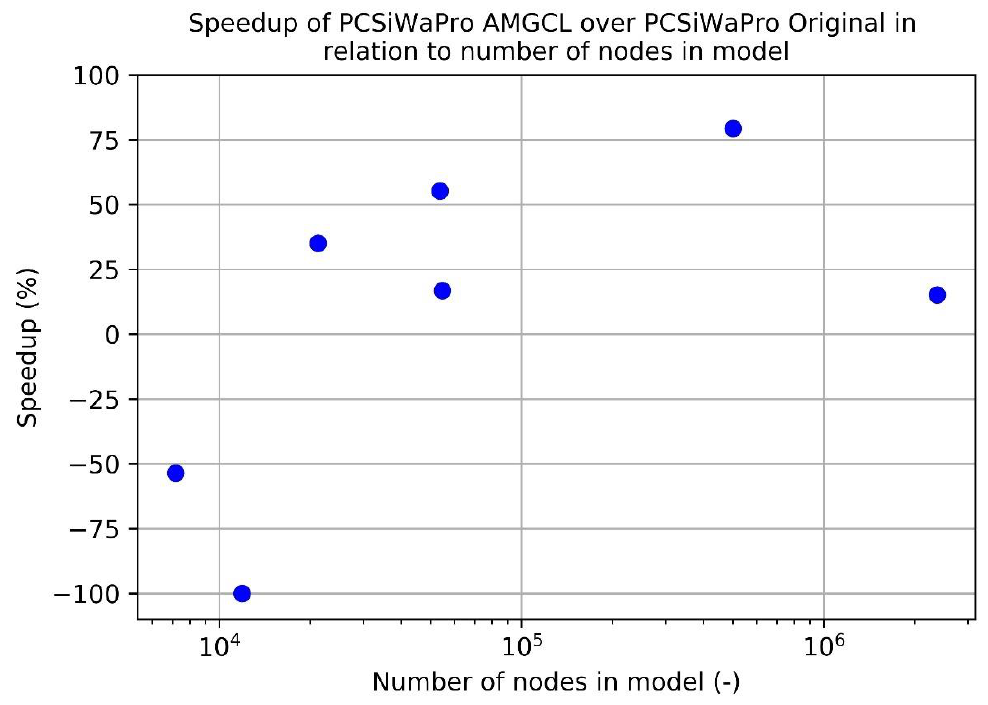
Figure 3. Comparison of the speedup achieved with PCSiWaPro AMGCL over PCSiWaPro Original in relation to the number of nodes in the model. One sees that PCSiWaPro AMGCL outperforms PCSiWaPro Original for models with 20,000 or more nodes.